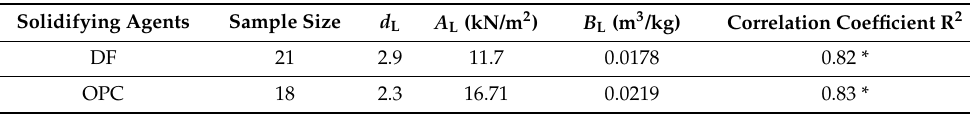
Figure 12. Relationship between ln q c and K L of clay stabilized by OPC or DF. ( a ) Stabilized clay by OPC, ( b ) Stabilized clay by DF. Table 5. Parameters of A L , B L , and d L in Equation (7) for stabilized